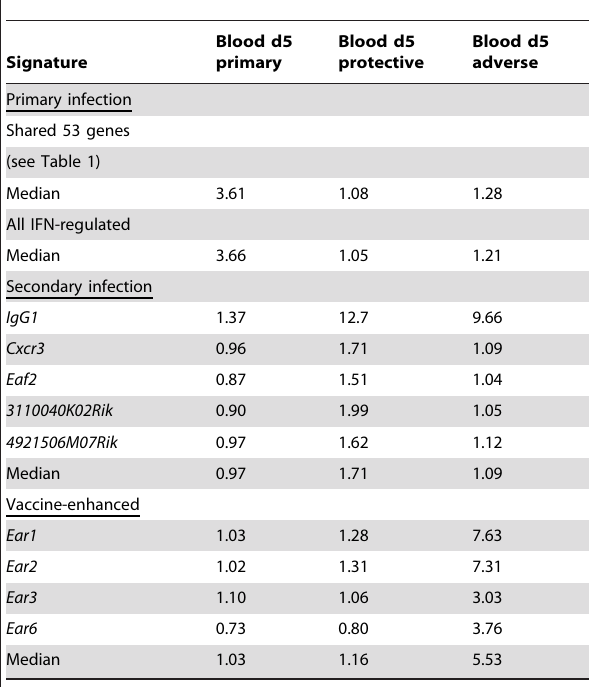
Table 2. Gene expression changes upon RSV infection in mice for primary infection, secondary infection, and vaccine- enhanced signatures in blood on day